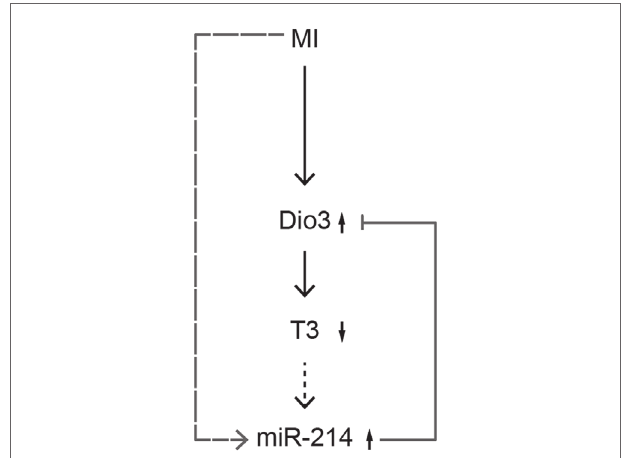
FigUre 8 | Proposed mechanism of Dio3 regulation by mir-214 . MI-induced cardiac stress results in upregulation of Dio3, leading to a reduced cardiac level of T3. The decreased level of T3 stimulates the expression of miR-214, which adds to the effects of other MI-induced regulatory pathways on miR-214 expression (the dotted arrow indicates that the relationship between T3 and miR-214 is inferred from indirect evidence). Increased miR-214 expression in turn decreases Dio3 expression, thereby dampening the reduction of T3 levels by Dio3. In this way, a negative feedback loop is created, possibly aimed at protecting the adult cardiomyocyte from the adverse effects of excessively low levels of T3.